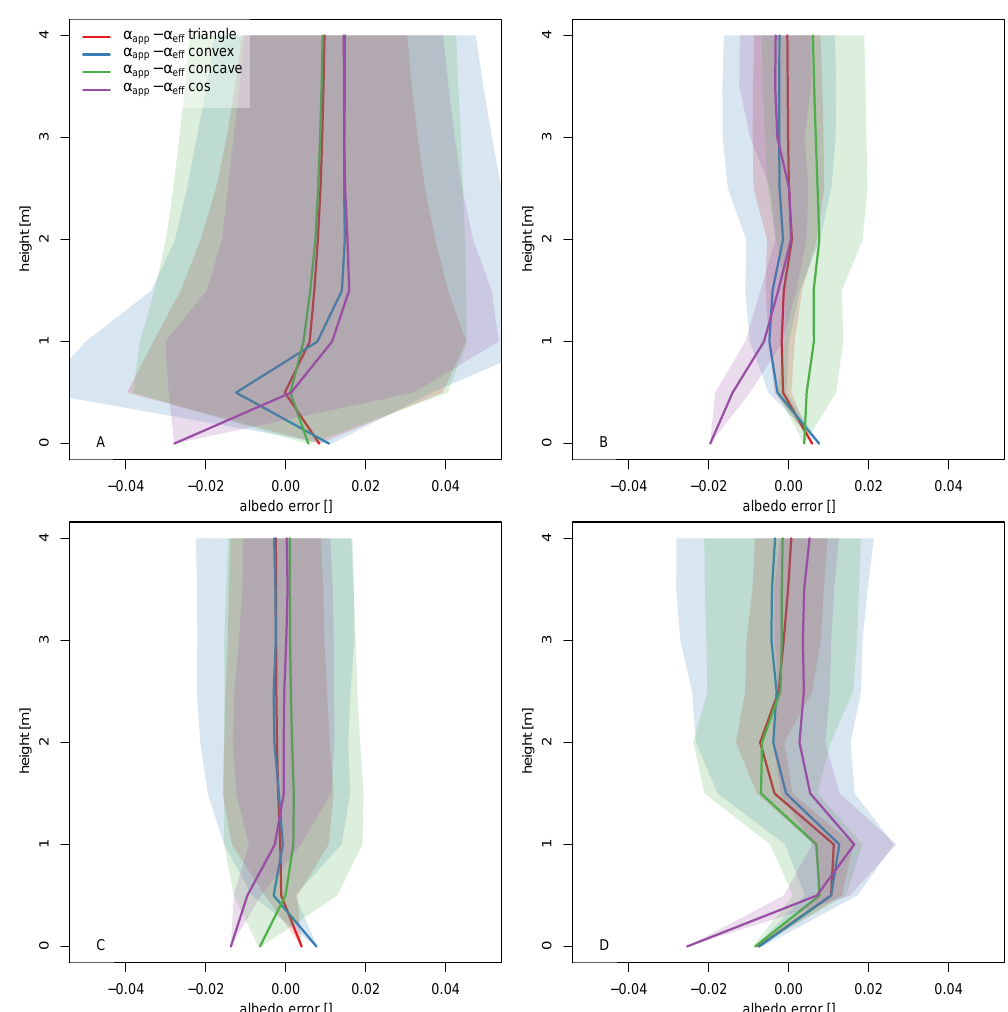
Figure 8. Mean difference between apparent and effective albedo (lines) and the 95% confidence interval (color shaded area) based on 75 samples per experiment for the different penitente shapes and for uniform material